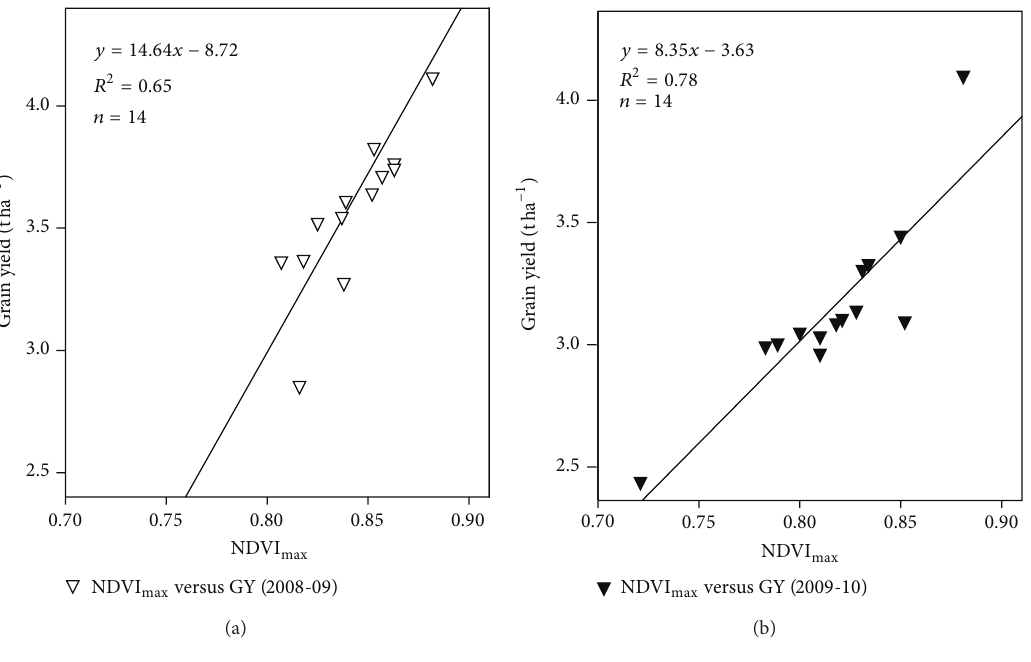
Figure 2: Relationship between grain yield and NDVI max .